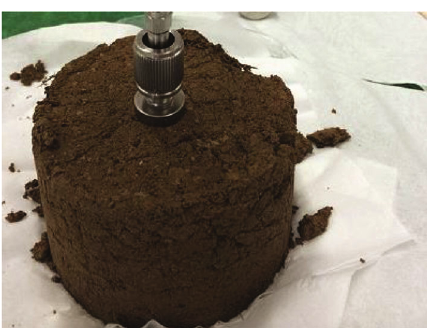
Figure 2: Dielectric permittivity